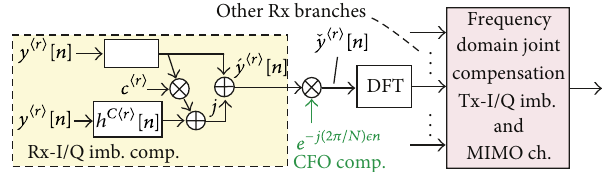
Figure 5: Hybrid domain compensation